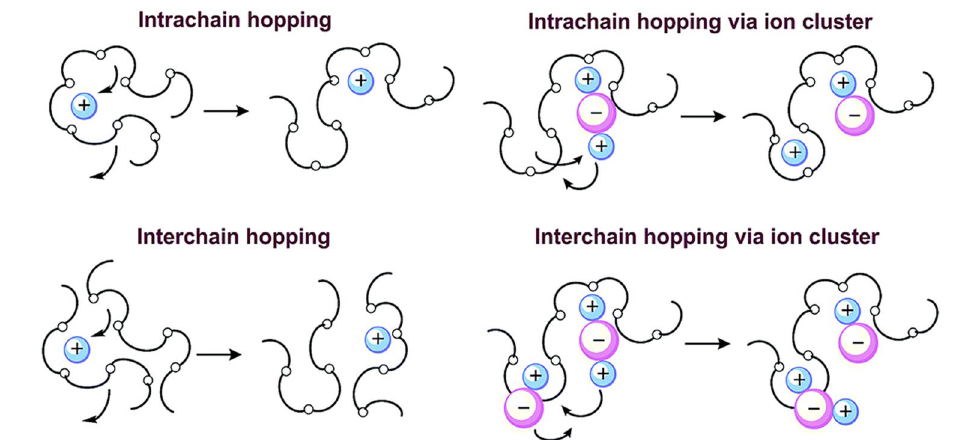
Fig. 8 Migration of lithium ion in polymers. Adapted with permission from Ref. [127]